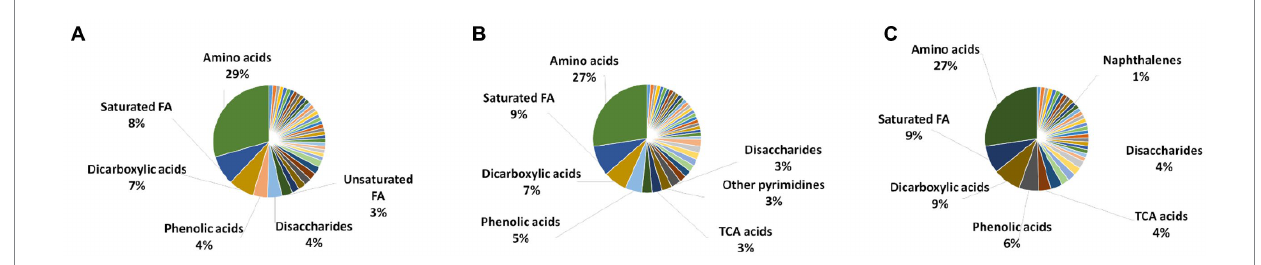
FIGURE 2 Chemical class analysis of identified metabolites. Pie-Chart of metabolite chemical class composition, identified using three different metabolite extraction methods n ≥ 4 (out of 6 independent experiments, selected using one-way ANOVA test with cutoff value of p ≤ 0.05) biological replicates were utilized to analyze the chemical class distribution. (A) freeze-thaw Cycle; (B) sonication Cycle; and (C) freeze-thaw Cycle followed by Sonication Cycle. The major metabolite class identified using each method was amino acids, followed by saturated fatty acids, dicarboxylic acids and phenolic acids (only major classes are shown in the figure). FA, fatty acids; TCA acids, trichloroacetic